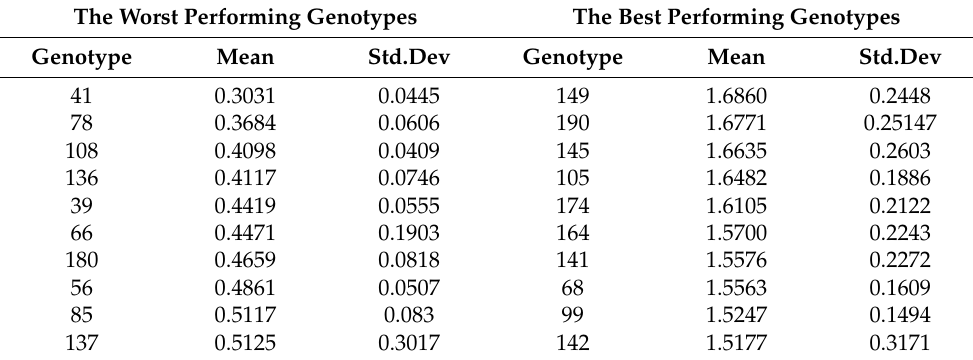
Table 4. Least and top performing genotypes using arithmetic mean